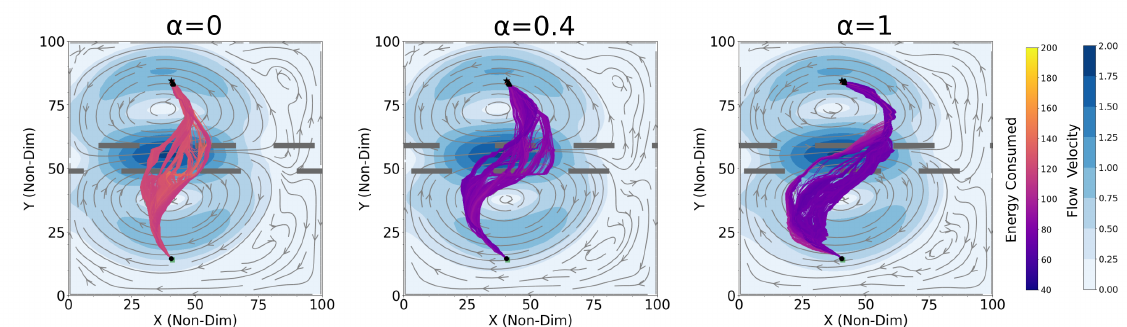
Figure 8. Shipping channel mission with an agent capable of executing an additional zero-speed action: Distribution of final trajectories by following the optimal policy for α = 0, α = 0.4 and α = 1 for the shipping channel mission. Here the agent is capable of an additional zero-speed